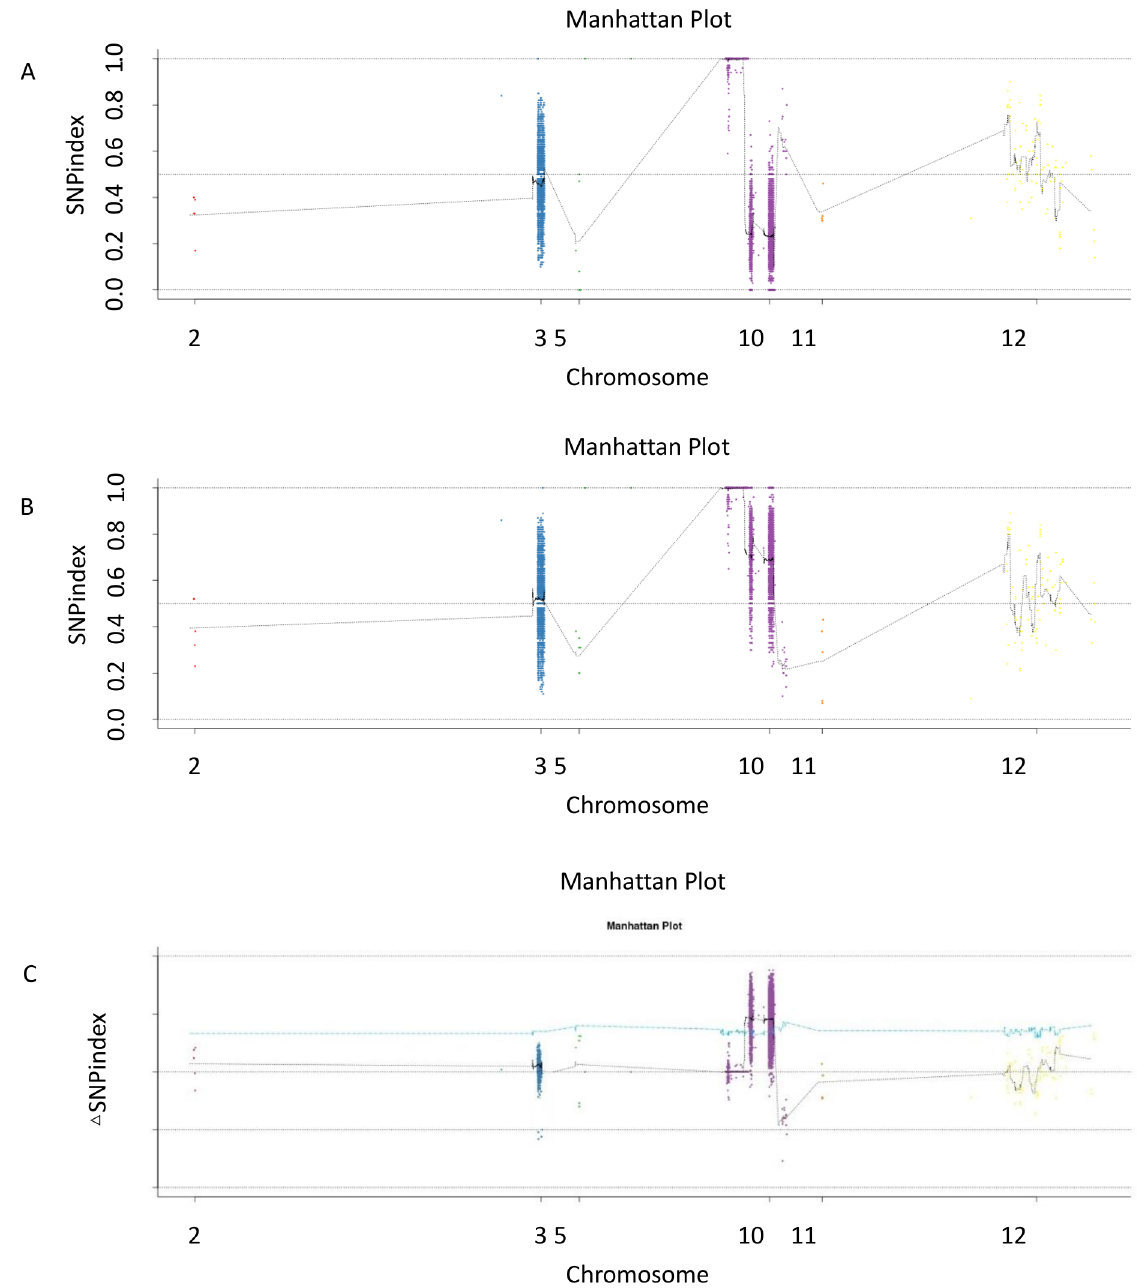
Fig 3. SNP-index graphs of H-pool (A), L-pool (B) and Δ (SNPindex) graph (C) fromSLAF-seq analysis. X-axis represents the positionof 12 rice chromosomes and Y-axis representsthe SNP-index.A candidate gene ( LESR ) locationwas identifiedin rice chromosome10 (8.61 to 9.69 Mb or 12.76 to 15.35 Mb) with the criteria that A the SNP-index in H-pool was near 0, B SNP-index in L-poolwas near 1, and C the Δ (SNP-index) was over the confidencevalue (P < 0.05).